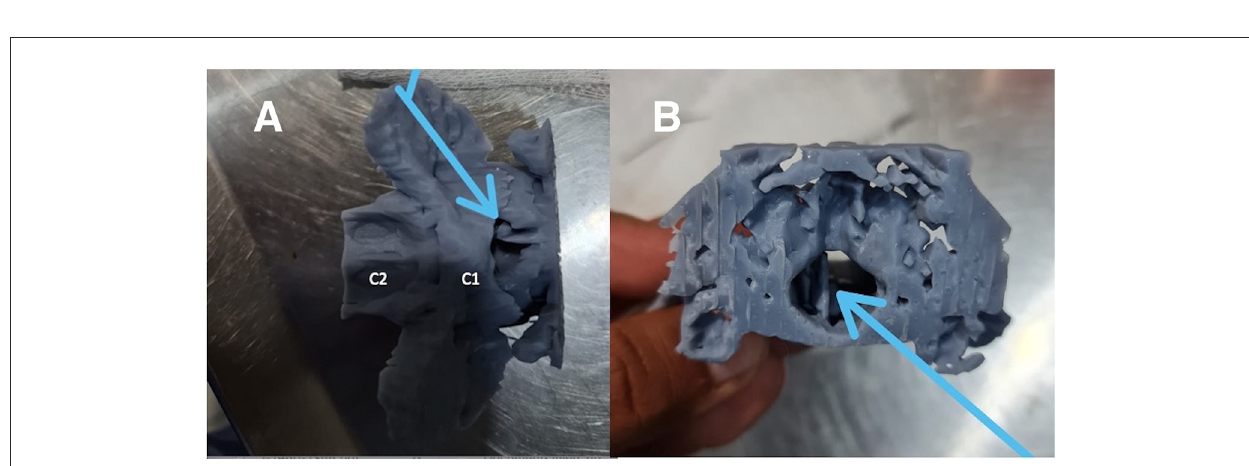
FIGURE3 Dorsal (A) and cranial (B) view of the 3D resin print of the caudal portion of the occipital bone and the C1 and C2 vertebrae. The blue arrows point to the metallic foreign